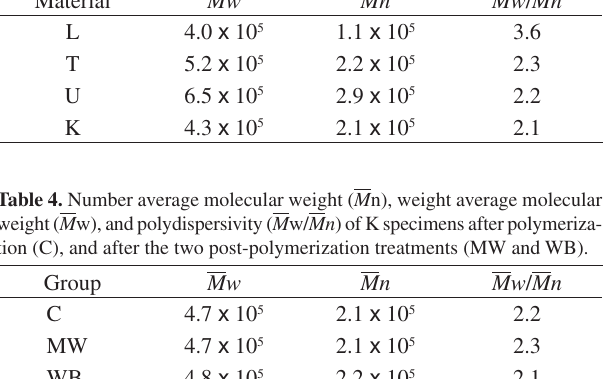
Table 3. Number average molecular weight ( Mn ), weight average molecular weight ( Mw ), and polydispersivity ( Mw / Mn ) of the original powder samples for all materials evaluated Material